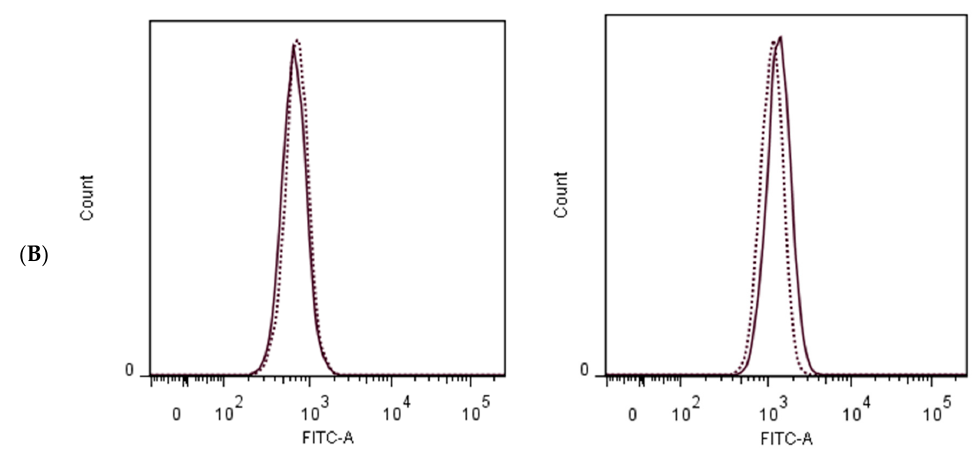
Figure 6. ABCB1 and ABCG2 do not confer resistance to BiQ-1. ( A ) BiQ-1 cytotoxicity in cells overexpressing ABCB1 (K562/ABCB1), ABCG2 (K562/ABCG2) and parental cells (K562) is shown. Viability of BiQ-1-treated cells was evaluated using the WST-1 assay, and IC 50 s were calculated as described in Materials and Methods; ( B ) BiQ-1 uptake was similar in ABCB1- and ABCG2-overexpressing cells in the presence of absence of the ABCB1-specific inhibitor PSC-833 or ABCG2 inhibitor fumitremorgin C.